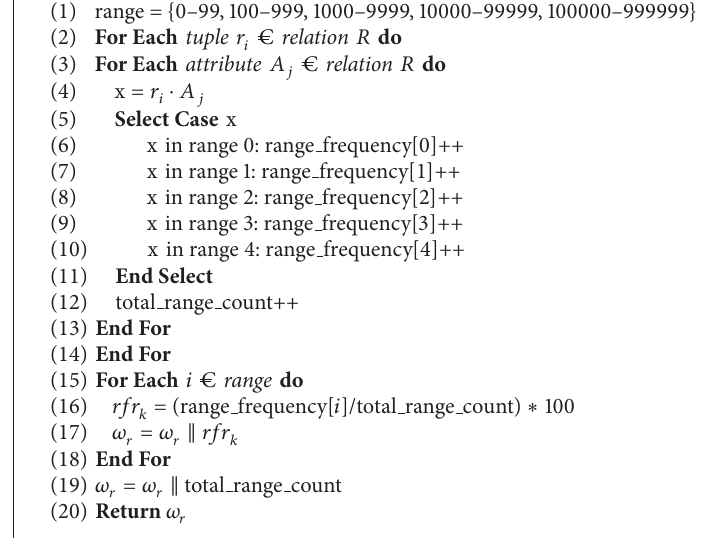
Algorithm 4: Range sub-watermark generation.